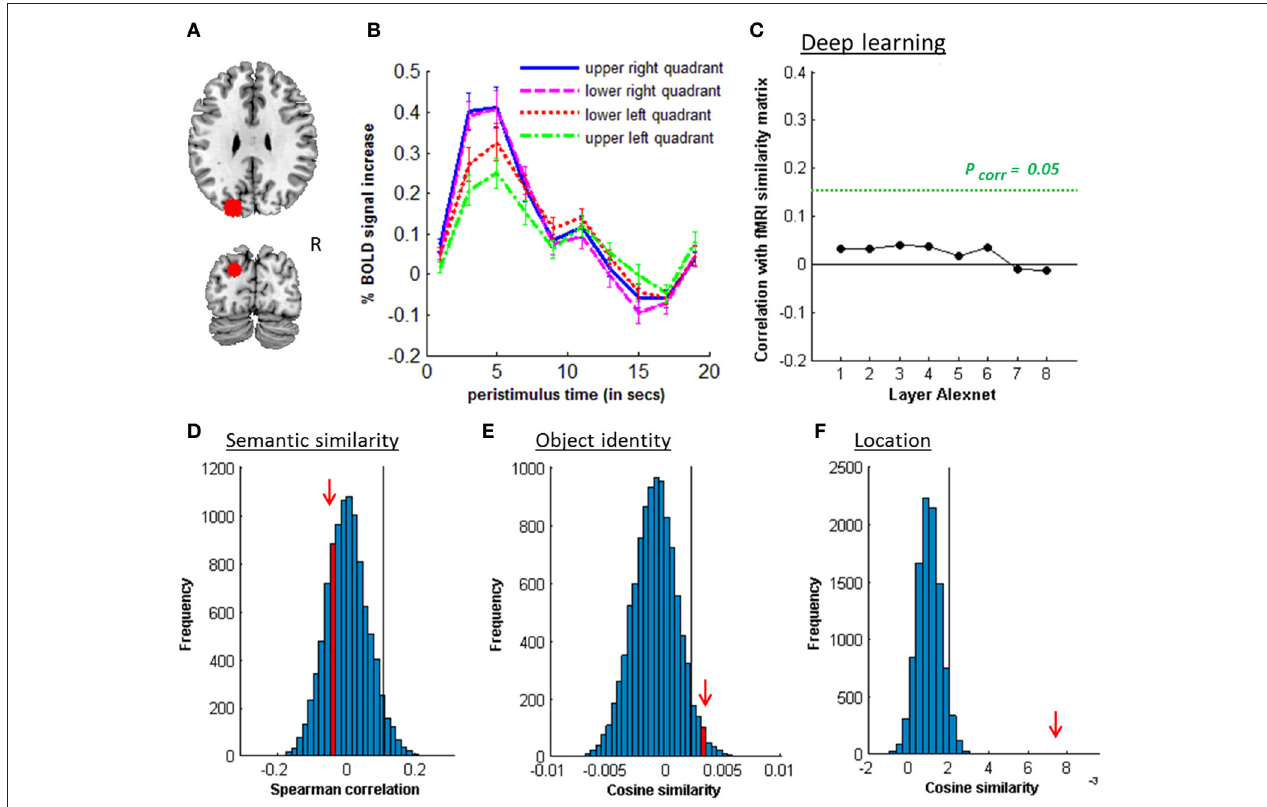
FIGURE 6 | MVPA effects in left posterior IPS. (A) Axial (z = 30) and coronal (y = − 80) slice depicting posterior IPS. (B) Peristimulus respons for each stimulus location. (C) Deep learning. Spearman correlation between the fMRI similarity matrix and the similarity matrices for the pictures for the eight layers of Alexnet. Statistical significance was evaluated by 10,000 random permutation labelings. The green dotted line corresponds to the statistical threshold corrected for the number of layers. (D) Probability distributions for the location-invariant semantic similarity effect. (E) Probability distributions for the location-invariant object identity effect. (F) Probability distributions for the location effect for real-life stimuli. The red arrow indicates the true Spearman correlation/cosine similarity in the distribution of correlations/cosine similarities generated by 10,000 random permutations. X-axis: Spearman correlation averaged over the group of subjects. Y-axis: absolute frequency of a given average Spearman correlation value across all random permutation labelings. Black line: 95th percentile of the distribution.